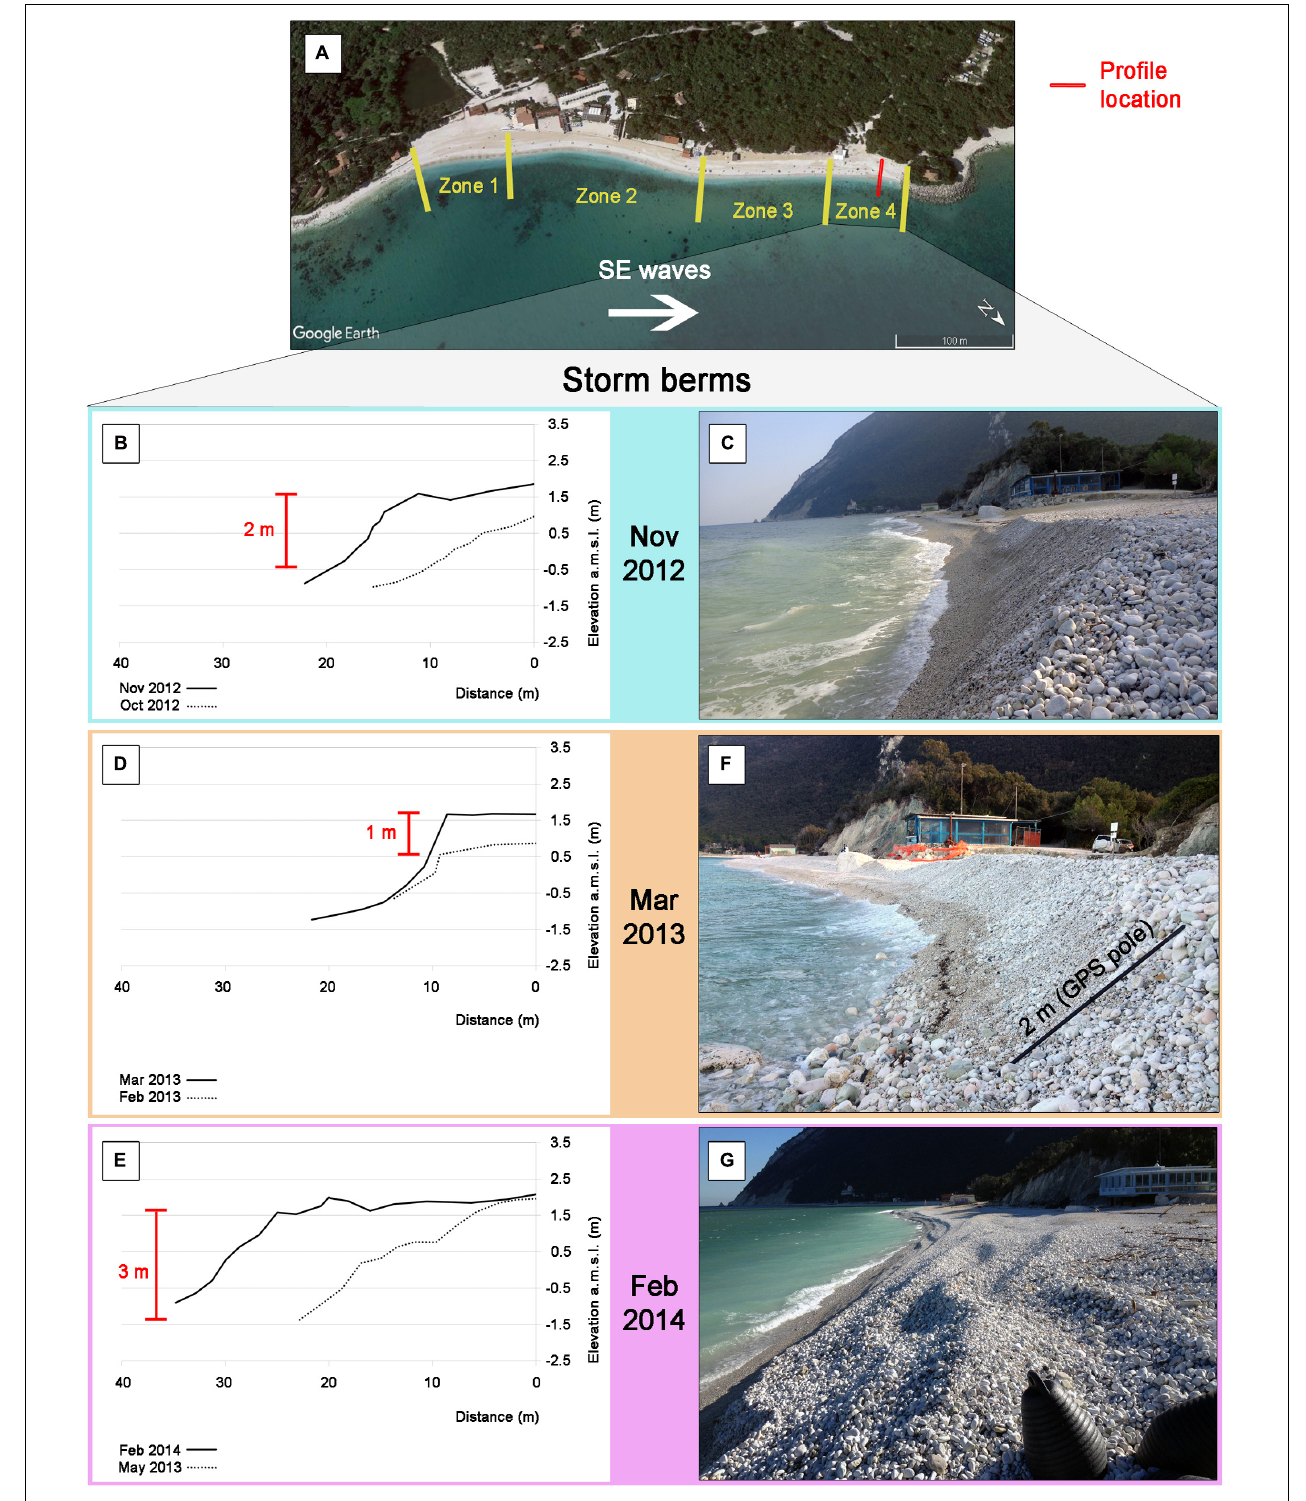
FIGURE 3 | View of the same beach portion of Portonovo (zone 4) after three different storms coming from the SE: (A) zone subdivision and focus on zone 4; (B) beach topography of November 2012 compared to the previous data available and (C) photo of the beach surface of November 2012; (D) beach topography of March 2013 compared to the previous data available and (E) photo of the beach surface of March 2013; (F) beach topography of February 2014 compared to the previous data available and (G) photo of the beach surface of February 2014.